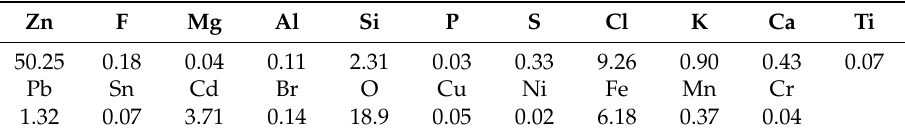
Table 1. Chemical composition of C.Z.O.